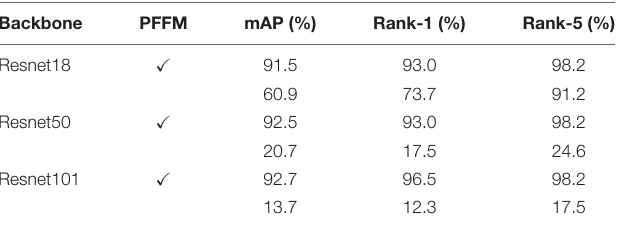
TABLE 3 | The evaluation of pyramidal feature fusion model (PFFM) using different backbones.